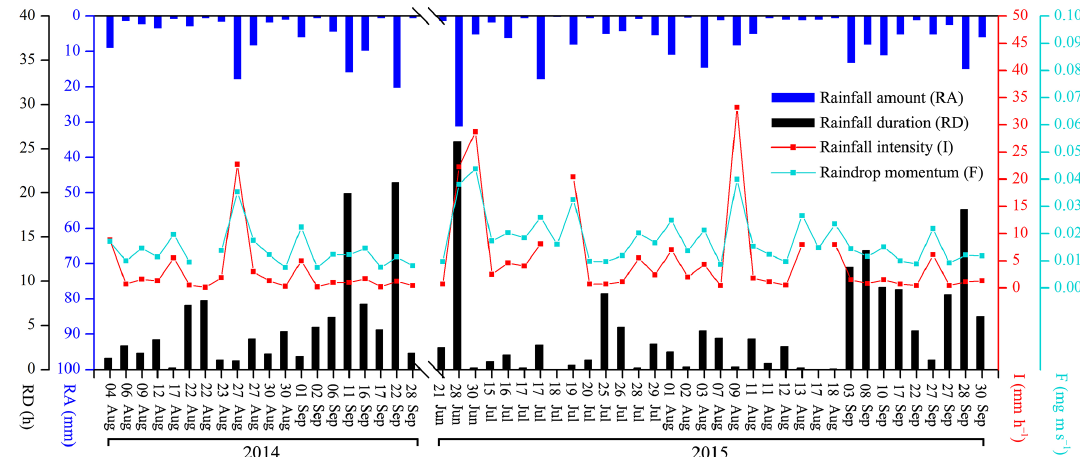
Figure 2. Inter-event variations in rainfall characteristics during the experimental